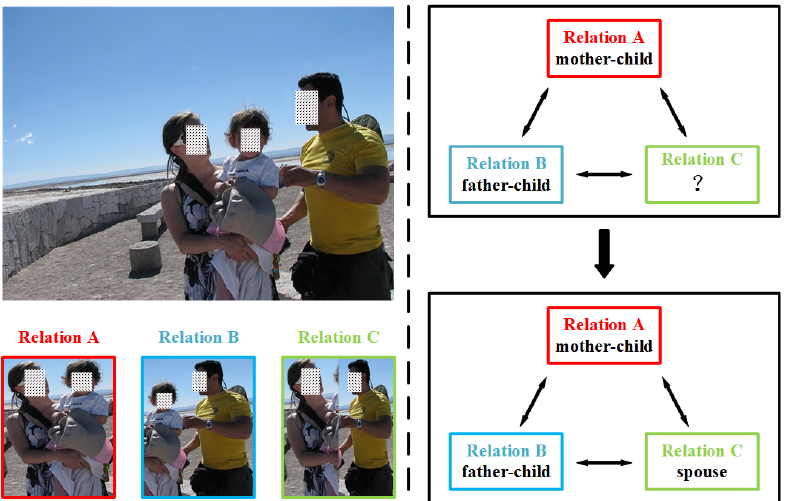
Figure 1. An example of the logical constraints among social relationships in one image. With relation A and relation B (‘ mother-child ’ and ‘ father-child ’ in the image), we can easily infer that relation C belongs to ‘ spouse ’ by the logical constraints. Note that all the displayed pictures are picked from People in Social Context (PISC)